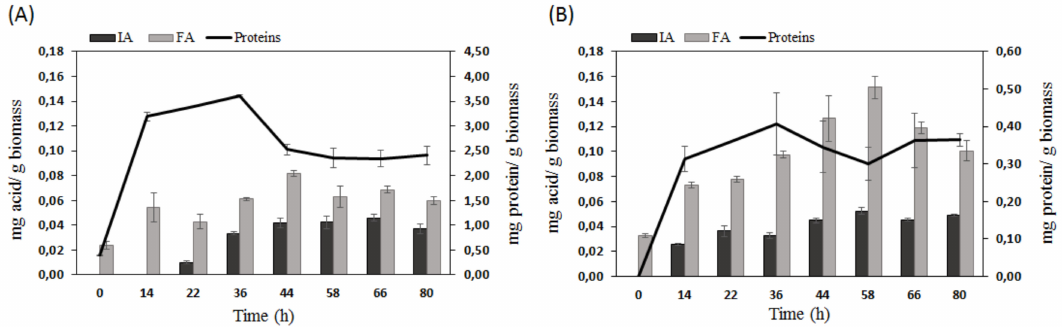
Figure 3. Kinetics of simultaneous saccharification and fermentation of wheat bran ( A ) and corn cobs ( B ) by A. oryzae